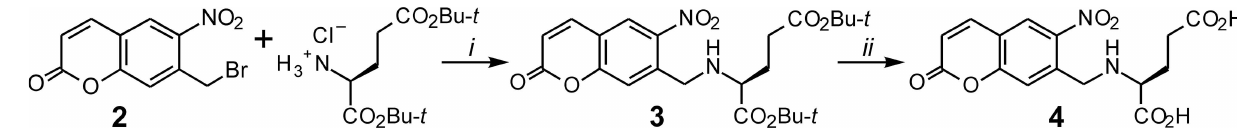
Fig 2. Synthesis of N -Ncm-Glu (glutamate caged on the α -amino group). Reagents and conditions: i ) Et 3 N, DMSO, rt, 4.5 h; ii ) HBr/ HOAC, 0˚C, 15 min.